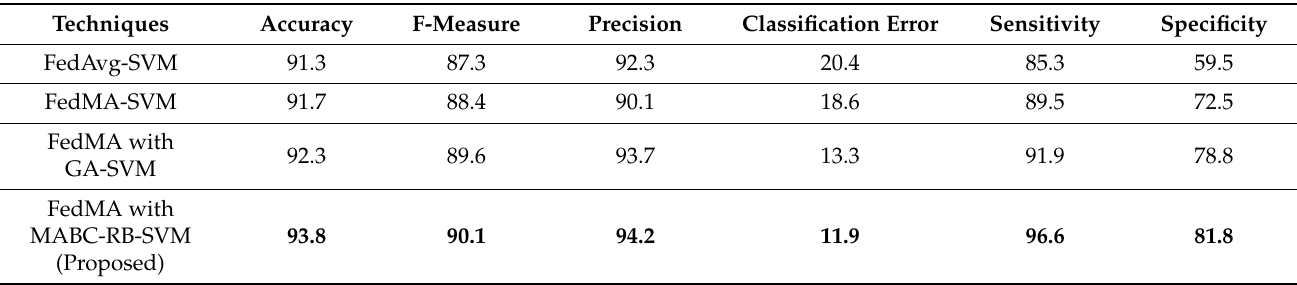
Table 4. Comparison of performance on features of the